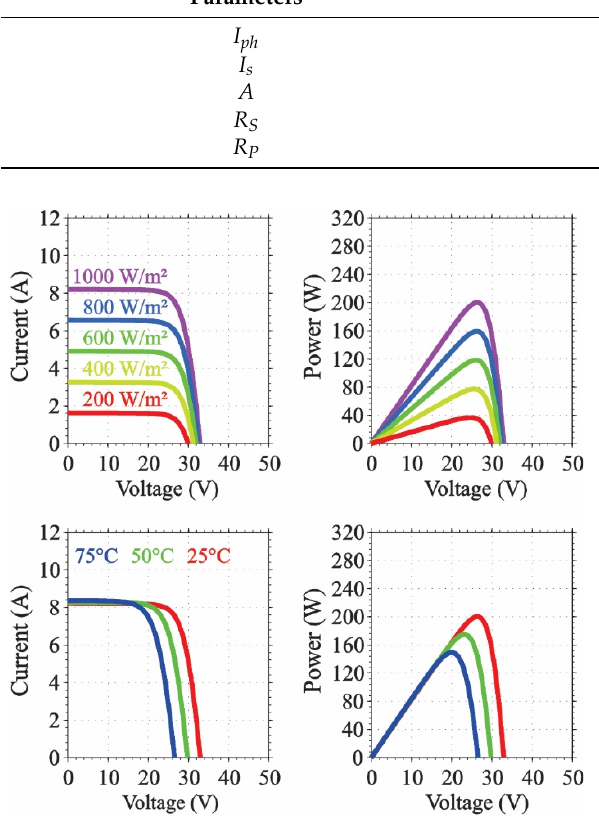
Figure 2. KC200GT I-V and P-V curves obtained from the one-diode model.